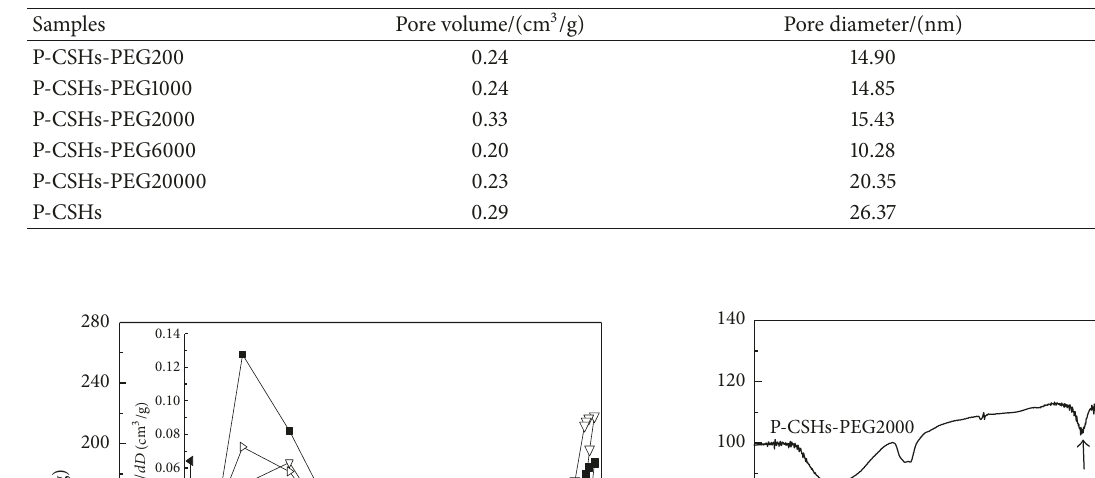
Table 2: The data of pore structure for different materials.